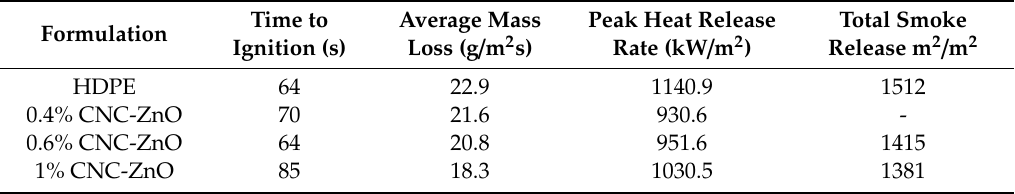
Table 2. Burn Characteristics of HDPE and CNC-ZnO formulations.